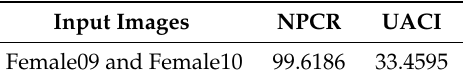
Table 4. NPCR and UACI